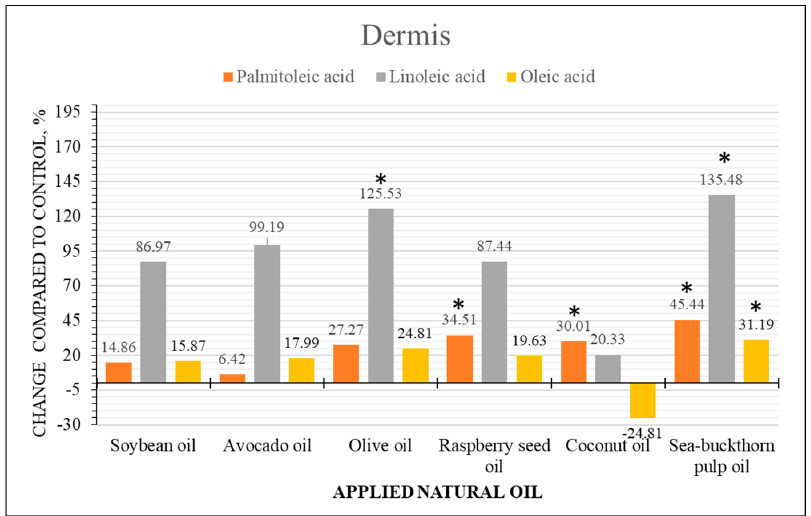
Figure 7. Comparison of FAs content changes in dermis of human skin ex vivo samples treated with natural oils. The bars represent the percentile changes of intensities detected in the dermis of natural oils treated samples and compared to the control. Statistically significant changes are marked * p < 0.05.